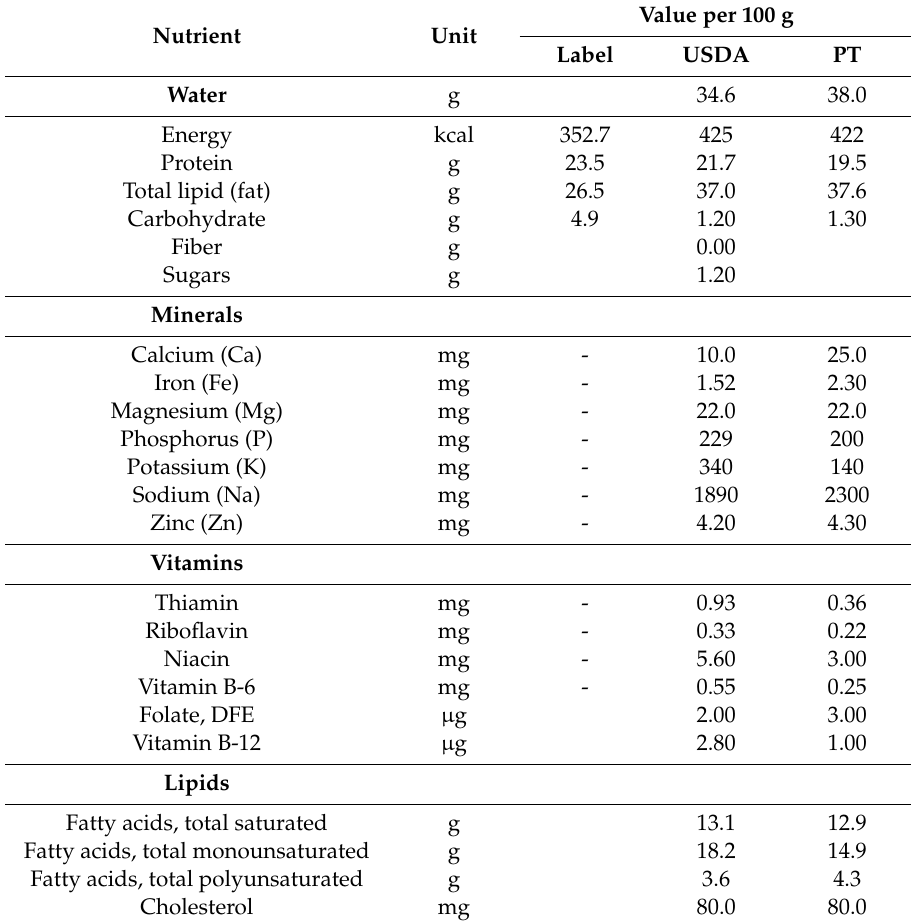
Table 1. Nutritional composition of salami according to the label information and according to the USDA Nutritional Database